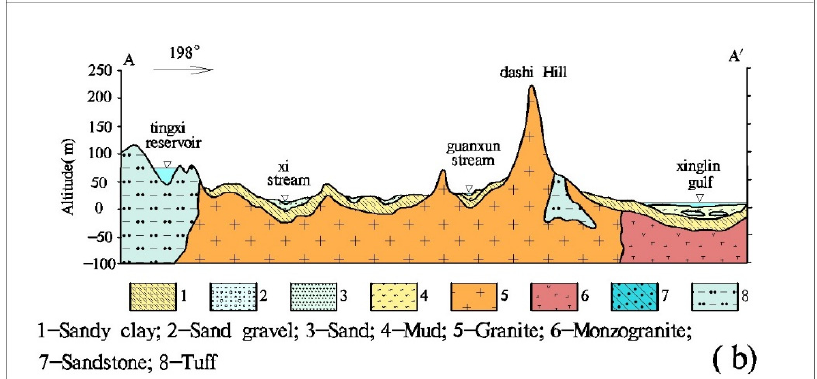
Figure 1. Hydrogeological conditions and sampling points in Xiamen, ( a ) Hydrogeological conditions and sampling points; ( b ) Typical hydrogeological